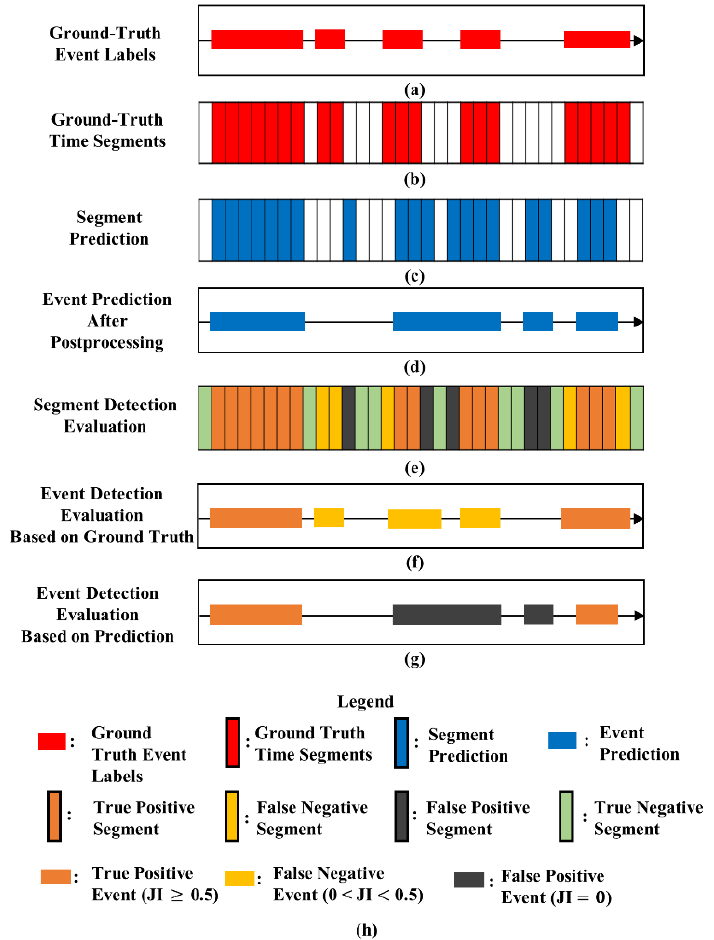
Figure 5. Illustration of segment- and event-detection evaluation: ( a ) ground-truth event labels, ( b ) ground-truth time segments, ( c ) segment prediction, ( d ) event prediction after postprocessing, ( e ) segment detection evaluation, ( f ) event evaluation based on ground-truth event labels, ( g ) event detection evaluation based on prediction, and ( h ) legend. JI: Jaccard index. This figure is adapted